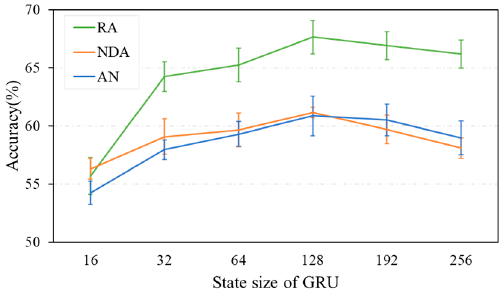
Figure 7. Accuracies of different data augmentation methods and state sizes. RA is randomly averaging, AN is noise addition, and NDA is non-augmentation.